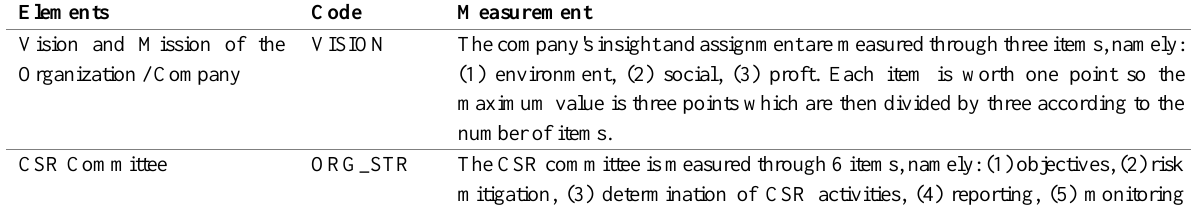
Table 1 : Measurement of sustainability report